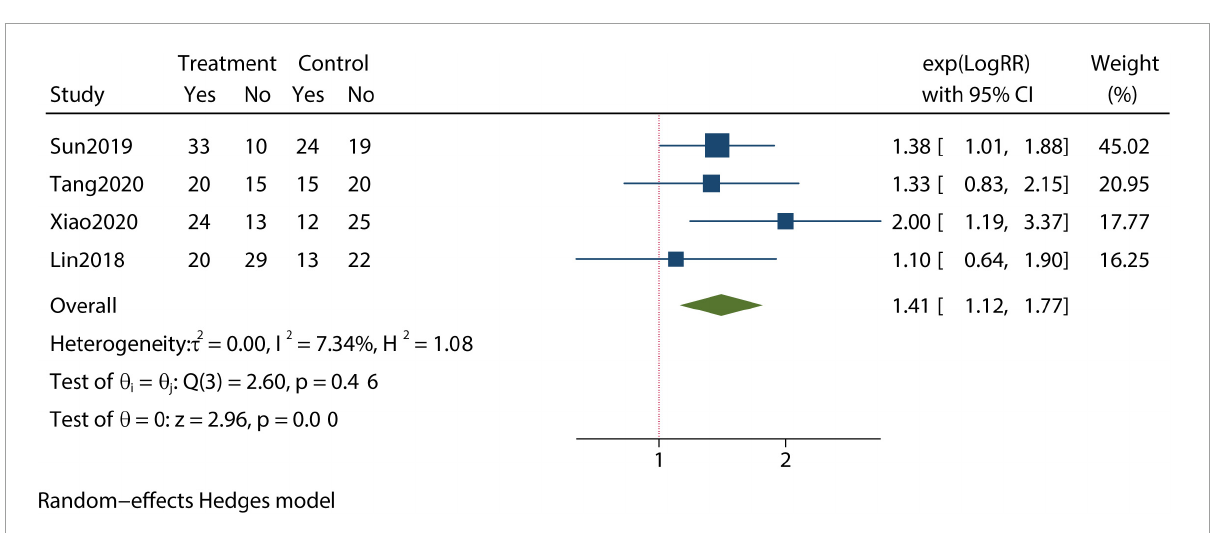
FIGURE5 Meta-analysis of compliance rate.